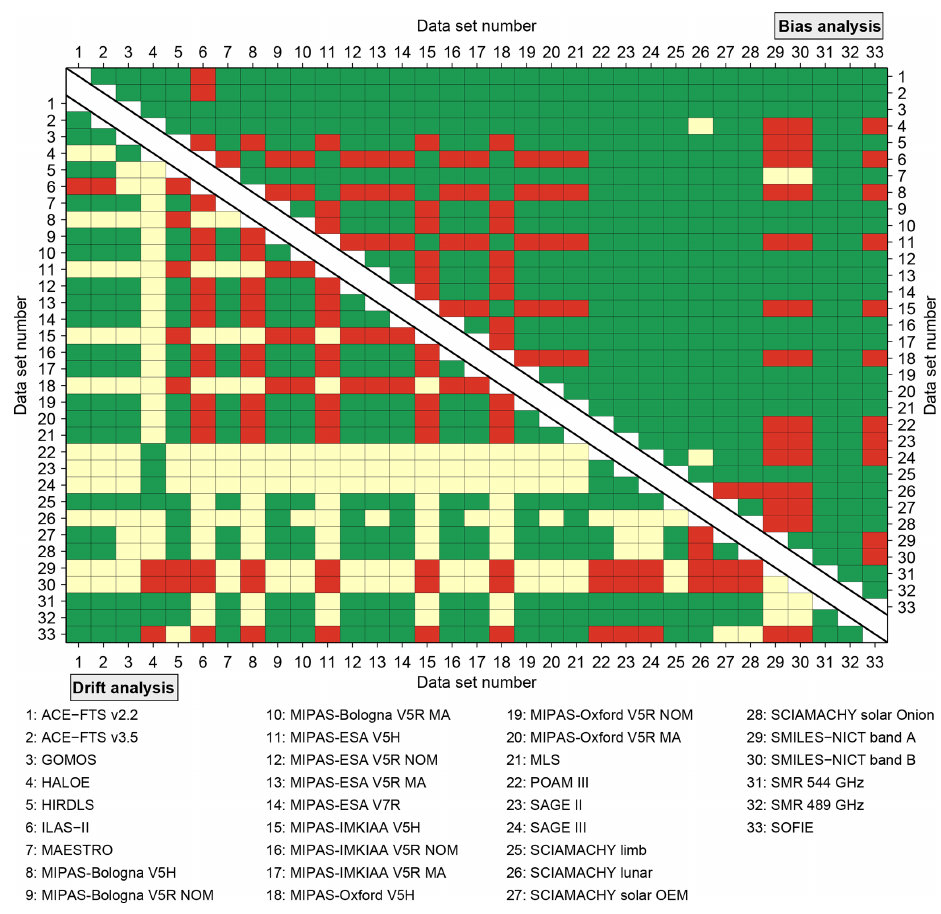
Figure 2. Overview which data sets were compared with each other in terms of biases (upper triangle) and drifts (lower triangle). Green means that comparisons were performed, while red indicates that this was not the case. Yellow means that comparisons were performed but the results were not considered any further since they did not meet the minimum criteria we defined in Sect. 3. For the bias comparisons this concerns the minimum number of coincidences (i.e. 20; see Sect. 3.3), while for the drift comparisons this involves the minimum overlap period (i.e. 36 months; see Sect.